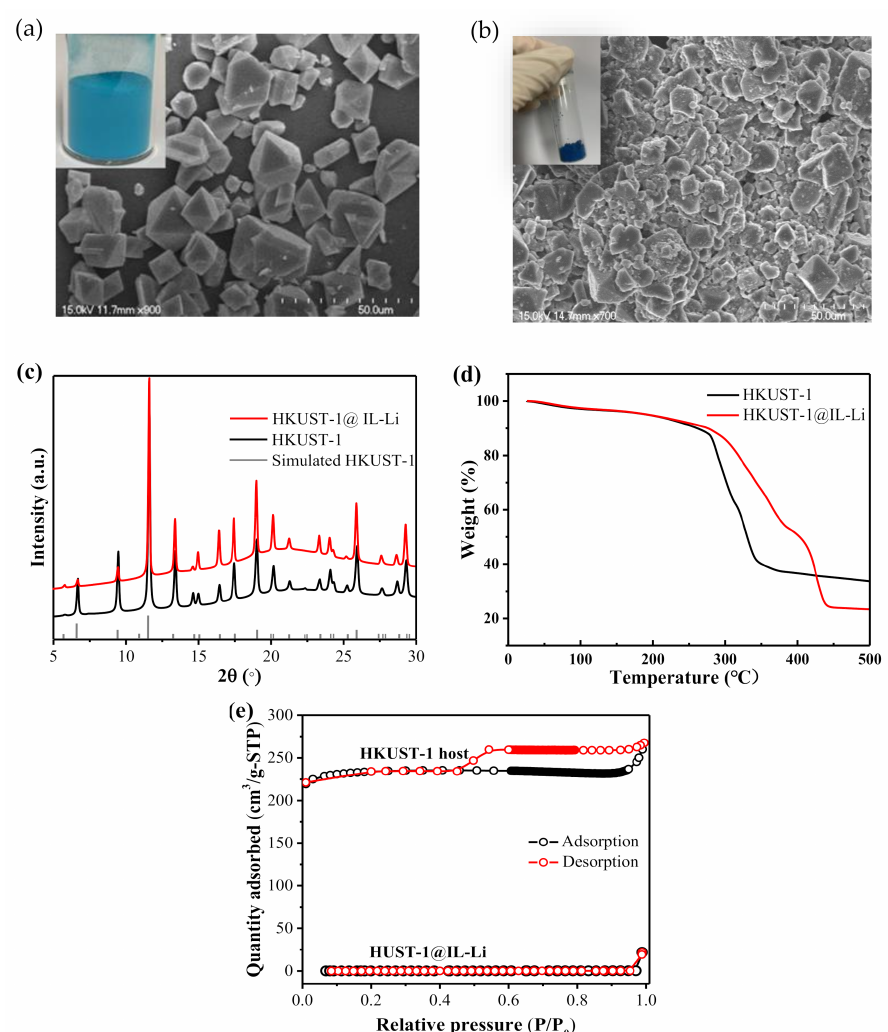
Figure 2. Structure and thermal characterizations of HKUST-1@IL-Li electrolytes. Scanning electron microscopy (SEM) images of ( a ) HKUST-1 particles and ( b ) HKUST-1@IL-Li electrolyte (insets: photographs of pristine HKUST-1 and HKUST-1@IL-Li). ( c ) X-ray diffraction (XRD)patterns of simulated HKUST-1, pristine HKUST-1, and HKUST-1@IL-Li. ( d ) Thermogravimetric analysis patterns and ( e ) Nitrogen adsorption/desorption isotherms of MOF host and